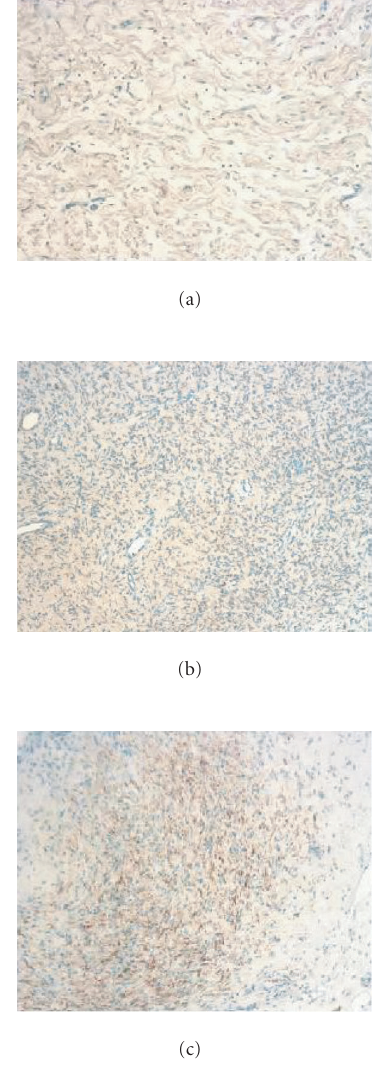
Figure 2. Evaluation for content of collagen in human neu- rofibroma xenografts in SCID mouse. Sections from formalin- fixed, para ffi n-embedded tissues were stained with Masson’s Trichrome and slides were examined using a brightfield micro- scope. Original tumor tissue (a) and the xenotransplant recov- ered 6 weeks after implantation without therapy (b) or with pir- fenidone treatment (c). Samples from the original tumor and 6- week-old implants were stained with Trichrome suggesting the presence of similar content of collagen. Tumors recovered from animals treated with pirfenidone did not display di ff erence in Trichrome staining, suggesting that 6-week therapy did not in- fluence the content of collagen.